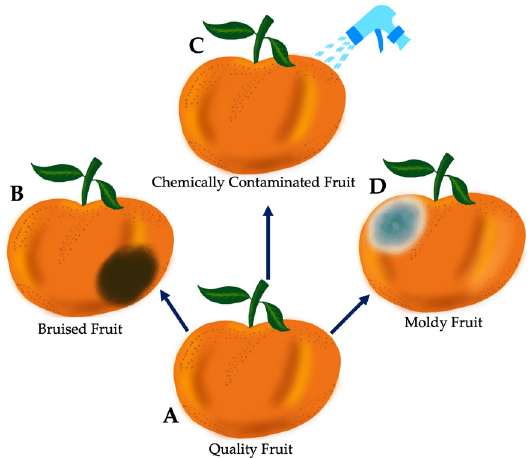
Figure 2. Example of food contamination. ( A ) without contamination, ( B ) physical, ( C ) chemical, and ( D )